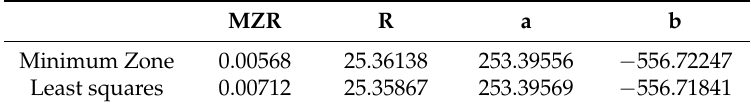
Table 6. Roundness measurement results Case 6. Roundness from dataset Table A4. Values in